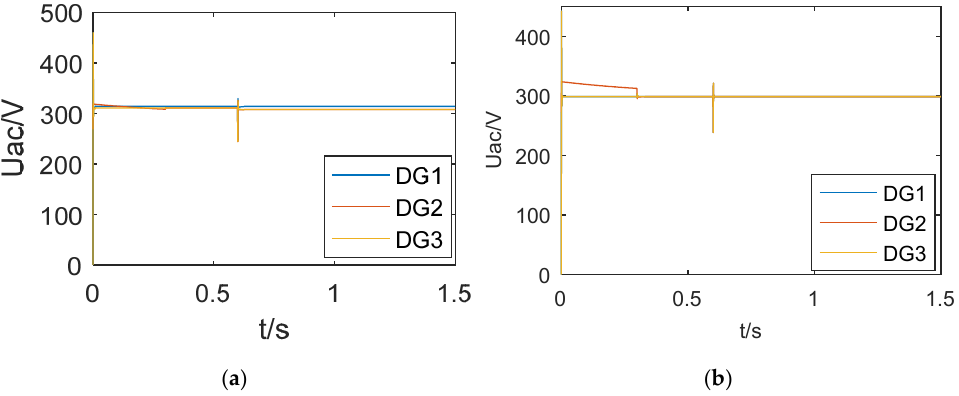
Figure 12. DC side voltage fluctuation process. ( a ) Schematic diagram of voltage fluctuation of each node at DC side under traditional droop control mode. ( b ) Schematic diagram of voltage fluctuation at each node on DC side based onOPPRA.